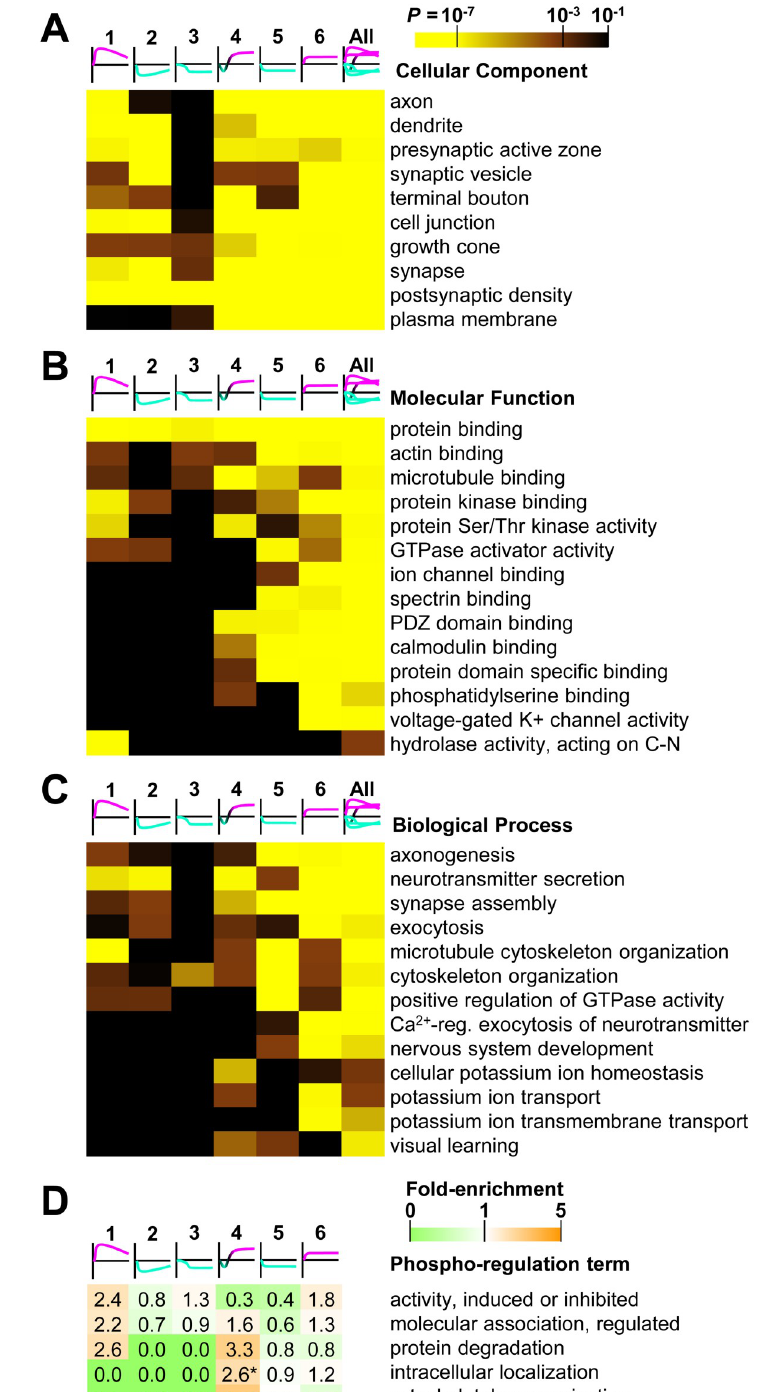
Fig 5. Enrichment of gene ontology terms for clusters of temporally regulated phosphopeptides. Heat maps are shown for the probability of (A) cellular component, (B) molecular function, and (C) biological process term enrichment for each cluster, using the indicated colour scale. Underlying data for this figure can be found in S1 Data. (D) Heat map and fold enrichment of phosphorylation site regulation ontology terms from PhosphoSitePlus [33] for each cluster ( � P < 0.05). GTPase, guanosine triphosphatase; reg., regulated; Ser/Thr, serine/threonine.